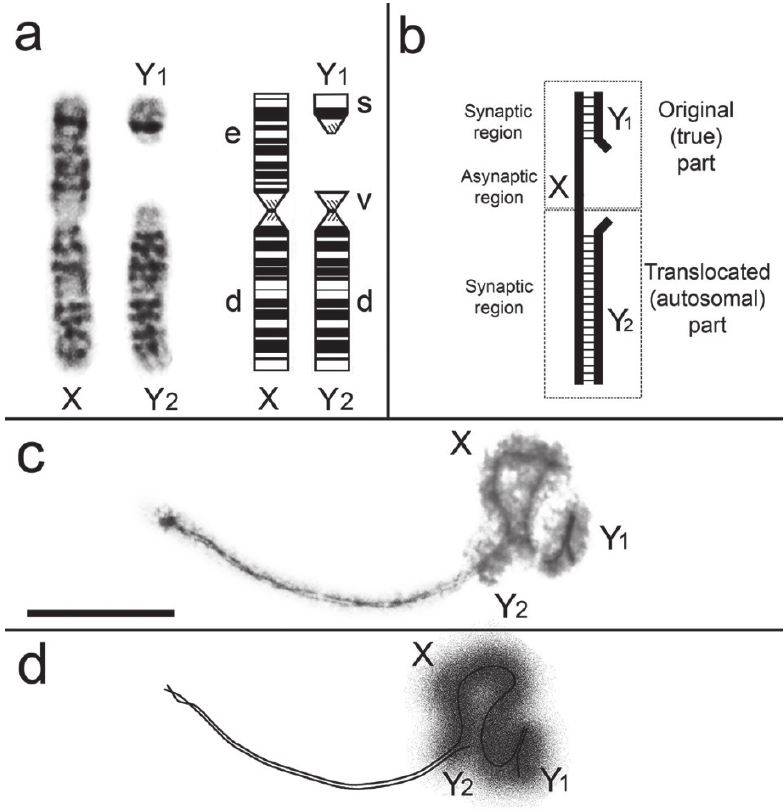
Figure 1. a G-banded sex chromosomes in the male common shrew (left) and ideogram with chromo- some arms labelled according to the alphabetic nomenclature of Searle et al. (1991) b Schematic diagram of the shrew pachytene sex trivalent, based on Pack et al. (1993) and our data c Electron micrograph of a shrew sex trivalent, XY Y at late pachytene. The true X region and the Y are surrounded by electron- 1 2 1 dense material. Scale bar: 5µm. d Diagram of the XY Y configuration as represented in Fig. 1 2